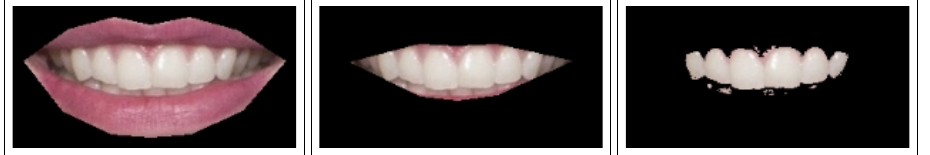
Figure 4. Illustration of the proposed representations for the mouth region OBR ( left ), IBR ( center ) and TR ( right ). Mouth image originates from LondonDB [46] dataset with application of keypoint generation by dlib [36], segmentation and cropping.